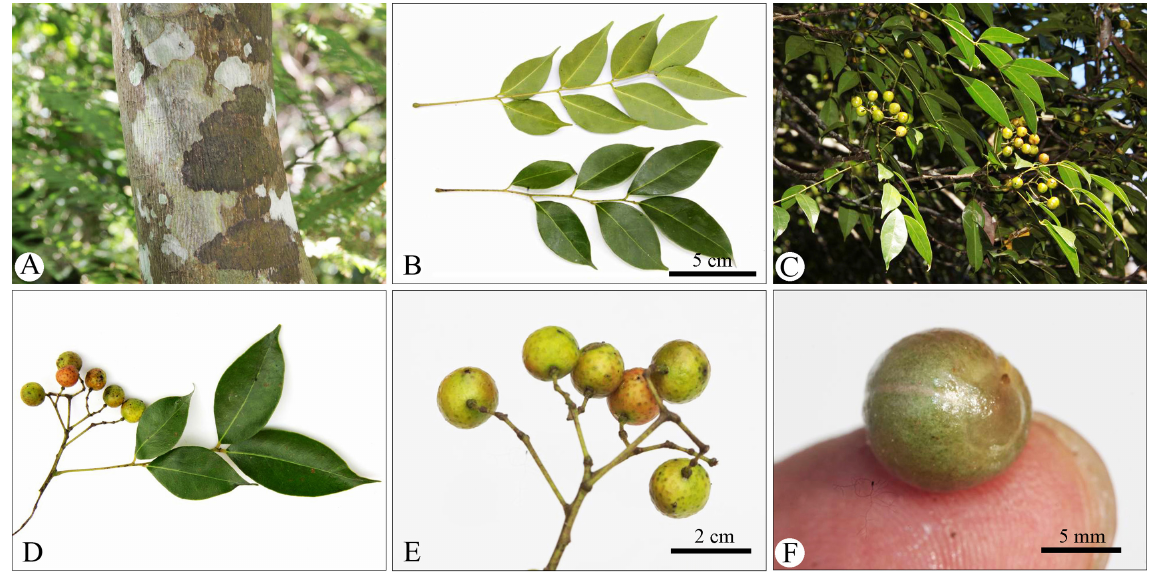
Fig. 5. Bergera euchrestifolia (Hayata) F.J.Mou comb. nov. A . Stem. B . Leaves. C–E . Fruits. F . Seed. Photos taken by Chuang His in Taiwan,